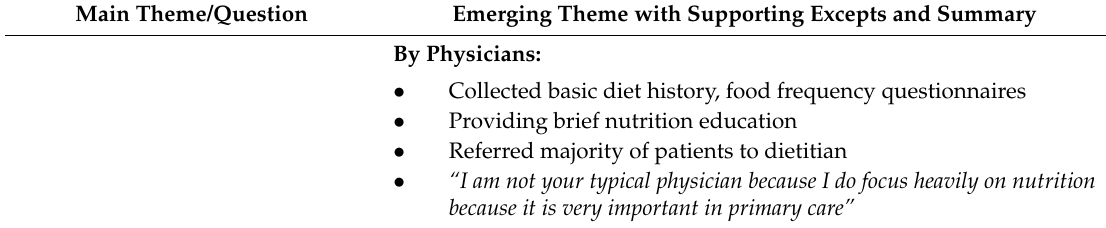
Table 6. Key themes identified by health care providers participating in focus group data collection ( n = 9) assessing the role and challenges for involving dietitians in multidisciplinary treatment of